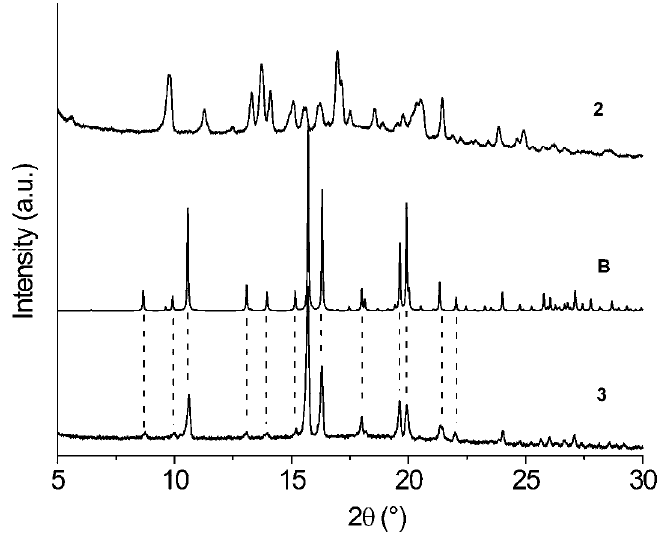
Figure 5. Experimental powder diffraction patterns of the new hydrate and monohydrate forms 2 and 3 , compared with the simulated powder pattern B generated from the single crystal structure of monohydrate form 3 .